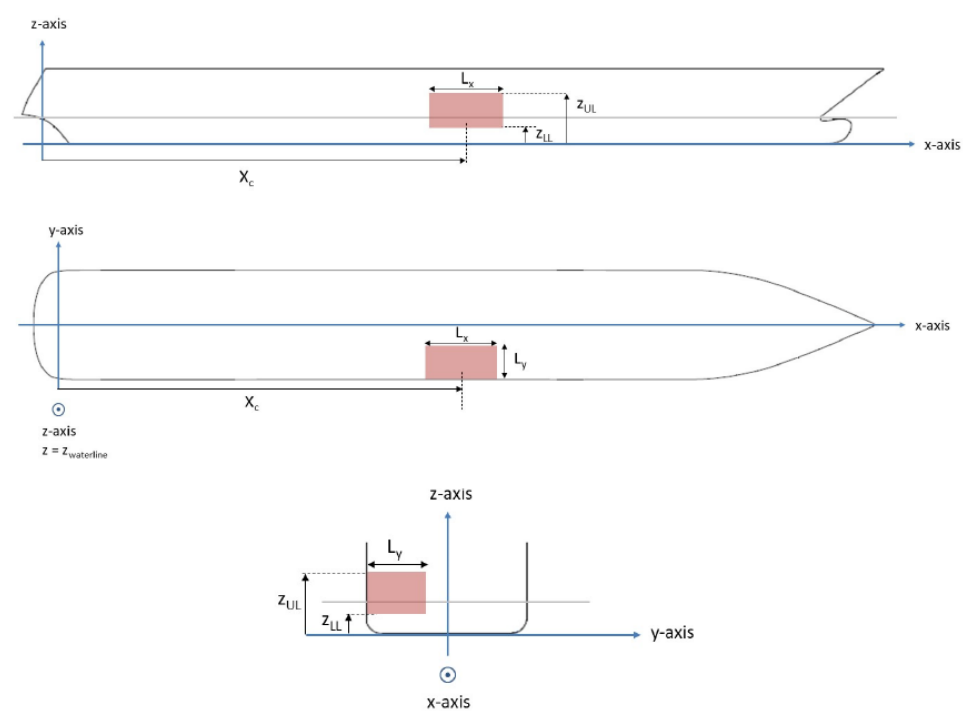
Figure 3. Geometric properties of a damage breach.